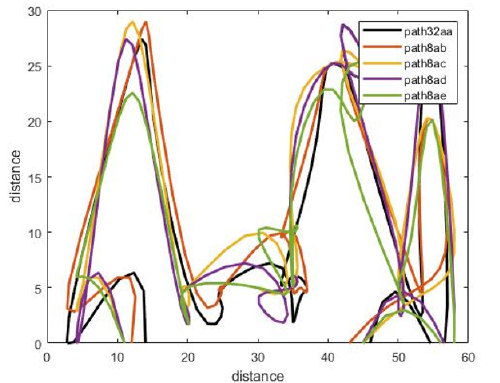
Figure 3. Walking paths in different observation for an abnormal pattern. The walking paths used represents the individual’s path while in the room. In total, a dataset of 180 images was constructed, consisting of normal and abnormal walking paths, and all dataset are gathered and uploaded to a data respiratory in this link: https://github. com/Ash83GH/Human-Activity-Recognition-Dataset (accessed on 17 December